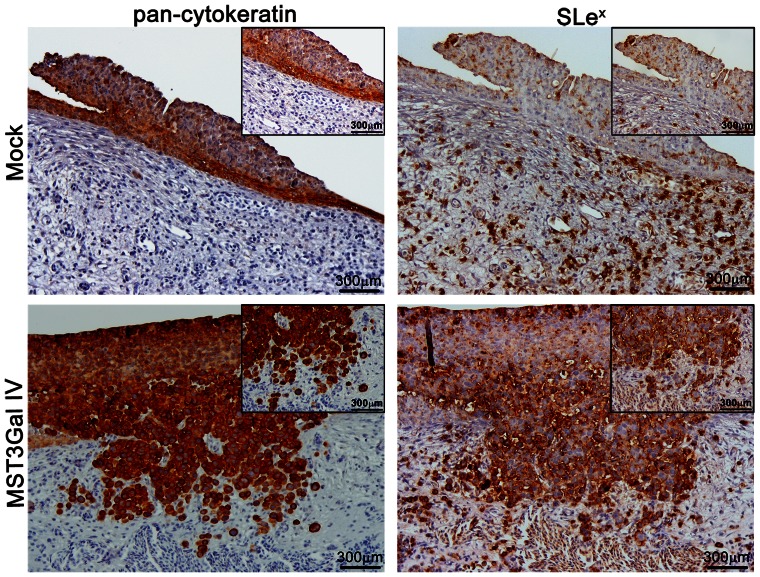
SLex expressing cells present an invasive phenotype in vivo chicken embryo chorioallantoic membrane (CAM) model.Transfected cells were inoculated in CAM and different parameters were evaluated after 3 days of inoculation. Invasive capacity of inoculated cells was evaluated by immunolabeling CAM tumors with human cytokeratin and SLex to assess the presence of human epithelial cells expressing SLex. Human cytokeratins immunostaining was used to prove the presence of inoculated human gastric carcinoma cells. SLex expression and the invasive capacity of cells were match up to cytokeratins expression. Immunostained tissues evidence the presence of SLex structures in CAM tumors from MST3Gal IV cells that, in constrast with Mock cells, invaded the CAM tissue.